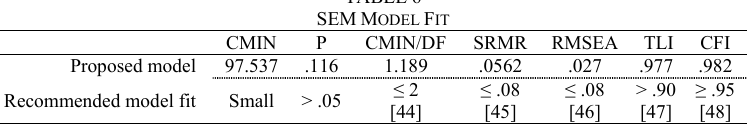
TABLE 6 SEM M ODEL F IT